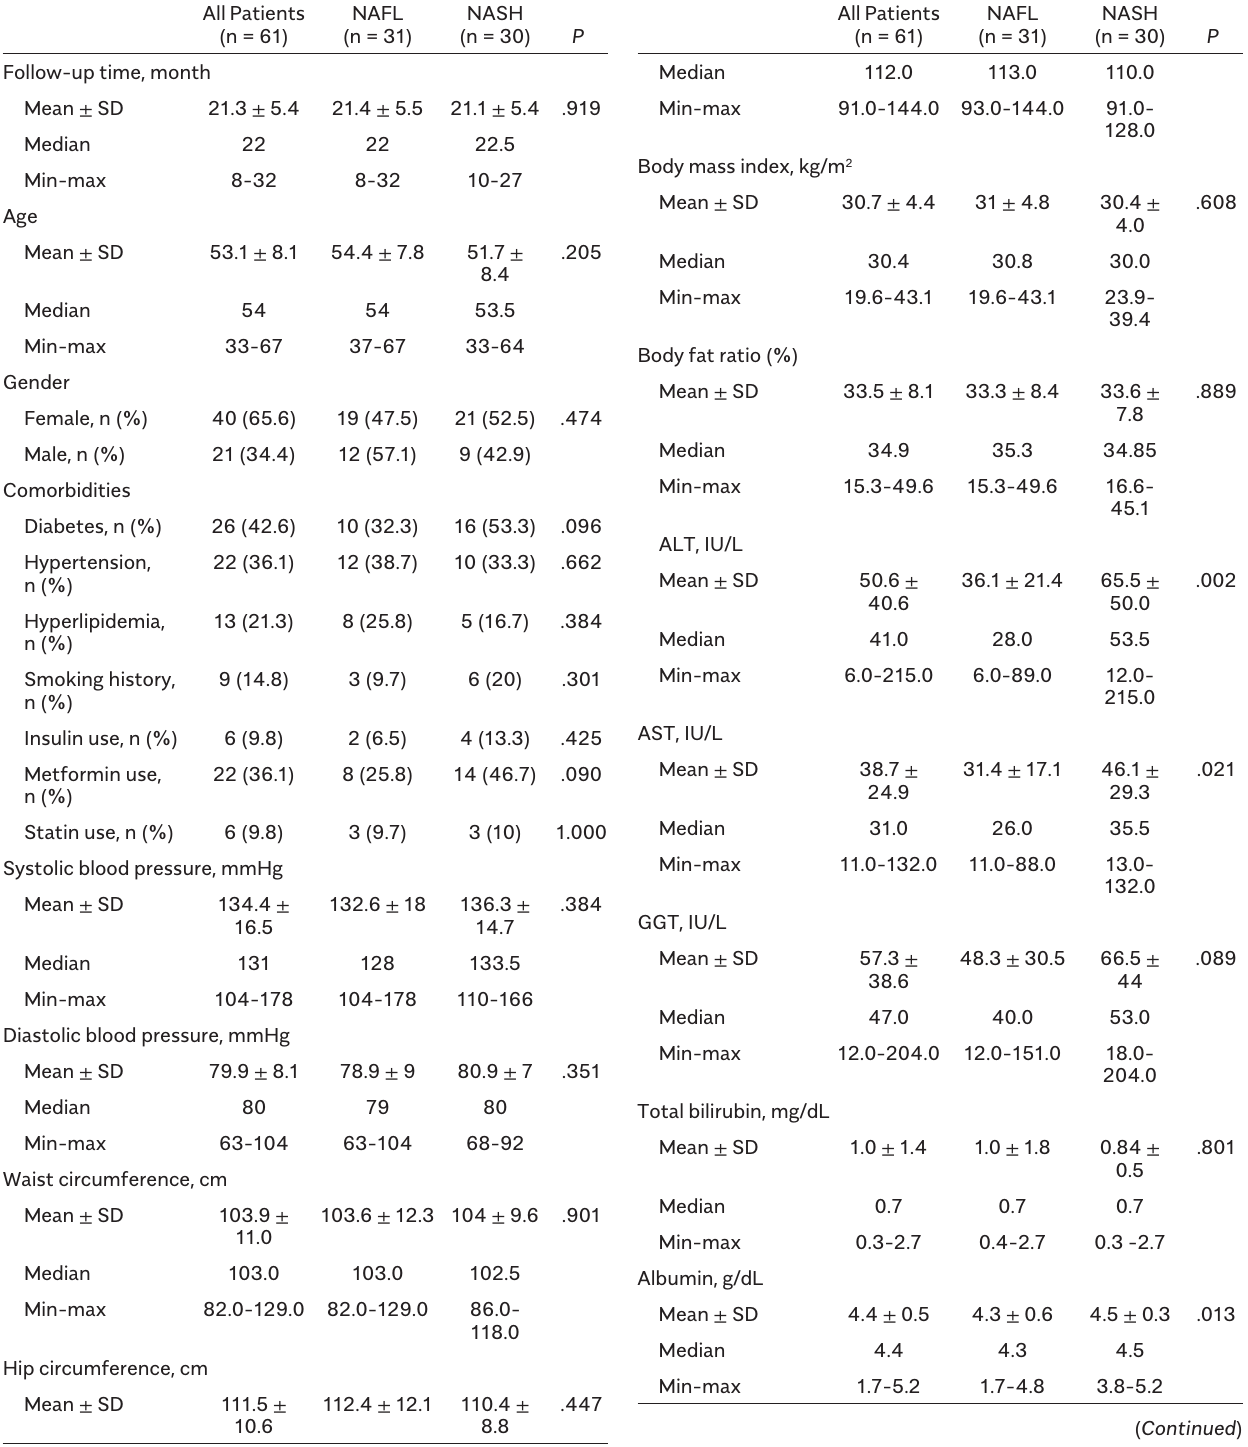
Table 1. Baseline Characteristics of NAFLD Patients who Are Included in the Study